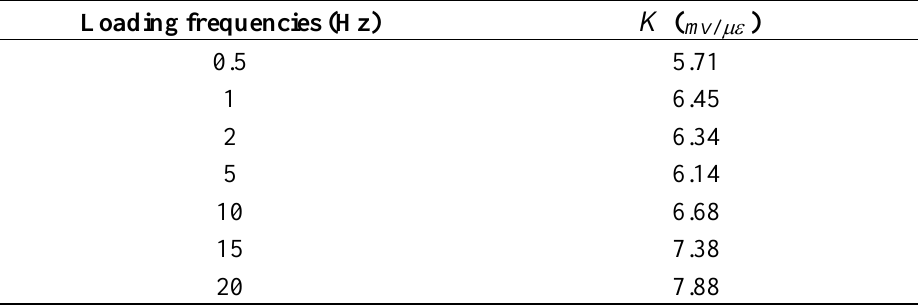
Table 7. K under different loading frequencies (0.5~20